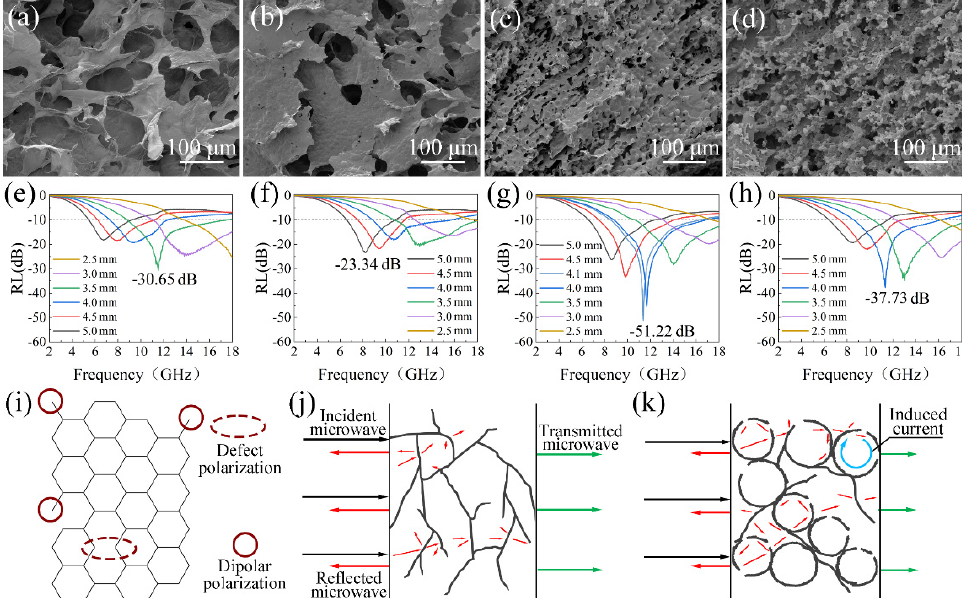
Figure 5. Effect of cell structure on the microwave absorption performance. SEM images of ( a ) GA, ( b ) OCGA-DE1, ( c ) OCGA-DE2, ( d ) OCGA-DE3. RL of ( e ) GA, ( f ) OCGA-DE1, ( g ) OCGA-DE2 and ( h ) OCGA-DE3. ( i ) Polarization from carbon. ( j ) Microwave absorption mechanism of GA (The black arrow indicates incident microwave, the red arrow indicates reflected microwave, and the green arrow indicates transmitted microwave). ( k ) Microwave absorption mechanism of OCGA.